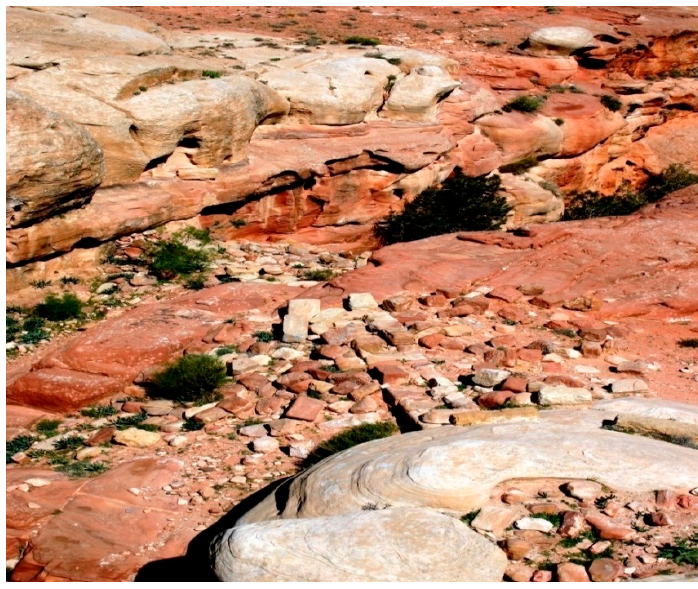
Figure 18. Remains of an abandoned early pipeline channel that would employ a large siphon to cross a valley originating from the spring source located north of the modern town.